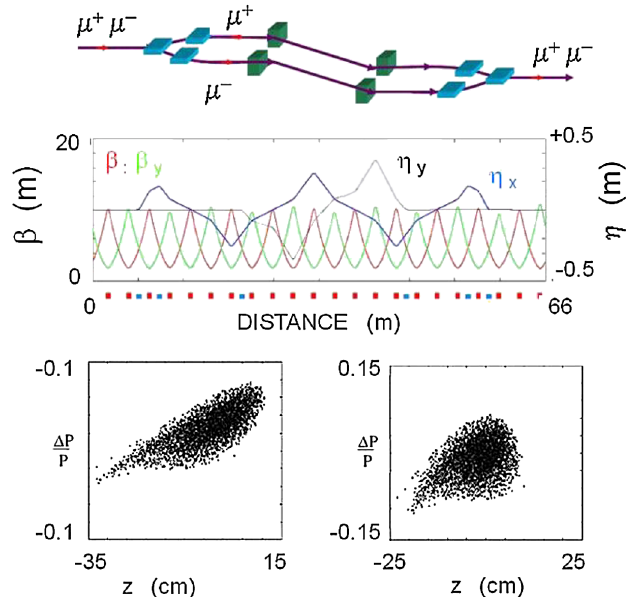
FIG. 12. (Color) Injection double chicane. Top: Horizontal and vertical magnet layout. Middle: Uniformly periodic optics form- ing a double achromat in the horizontal and vertical plane. Bottom: Particle tracking results for the longitudinal phase space ( s , (cid:1) p=p ) at the beginning (left) and at the end (right) of the double chicane.